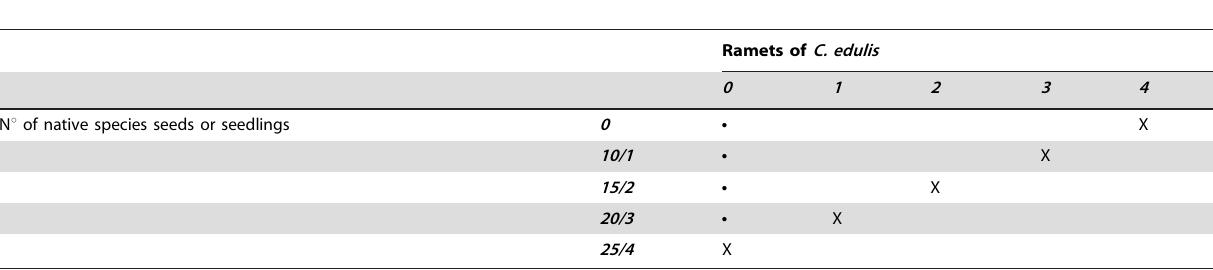
Table 1. Methodological scheme for greenhouse experiment.